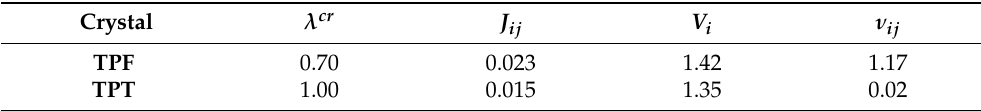
Table 4. Reorganisation energies in the crystal ( λ cr in eV), exciton couplings ( J ij in eV) for the dimer with smaller centroid distances, exciton hopping ( ν ij in 10 10 s − 1 ) in TPF and TPT . V i are the values of Voronoi volumes of the crystals computed with fromage